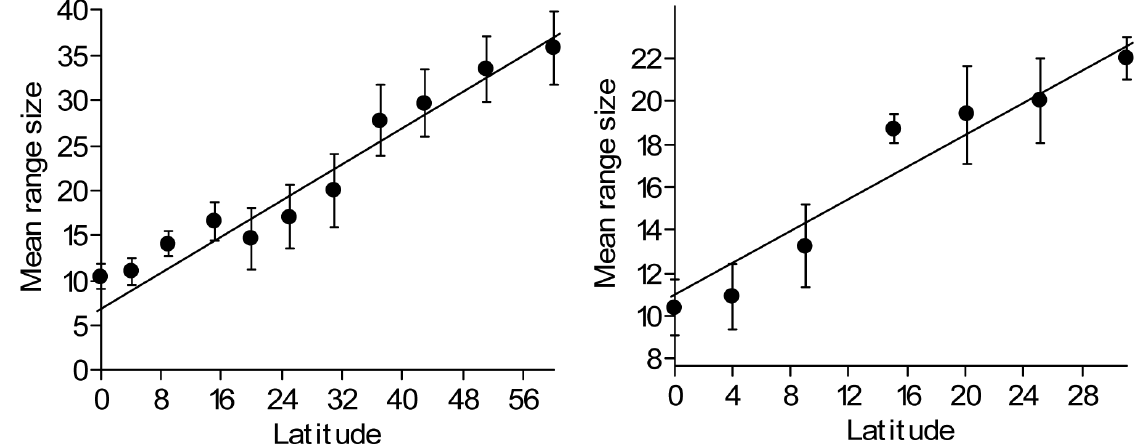
Figure 1. Relationships between latitude (x-axis, in °N) and mean range size (y-axis, in number of cells) for Sciuridae genera in the Northern hemisphere. Statistics of the regression: r = 0.949, mean range = 0.456 latitude + 8.64. Error bars are given for each data point.